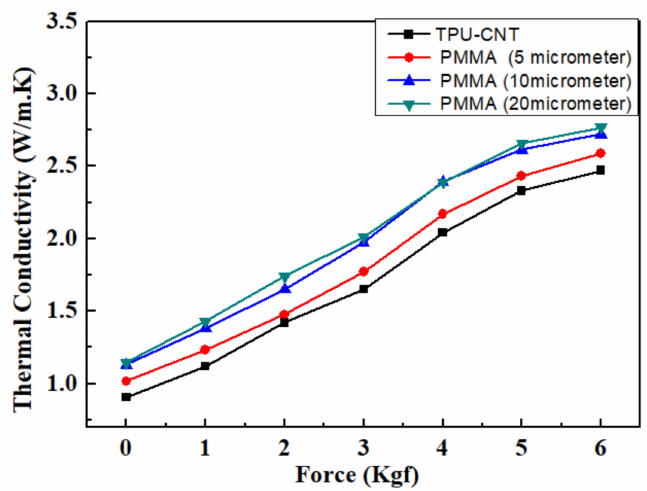
Figure 8 . Thermal conductivity curve as a function of external